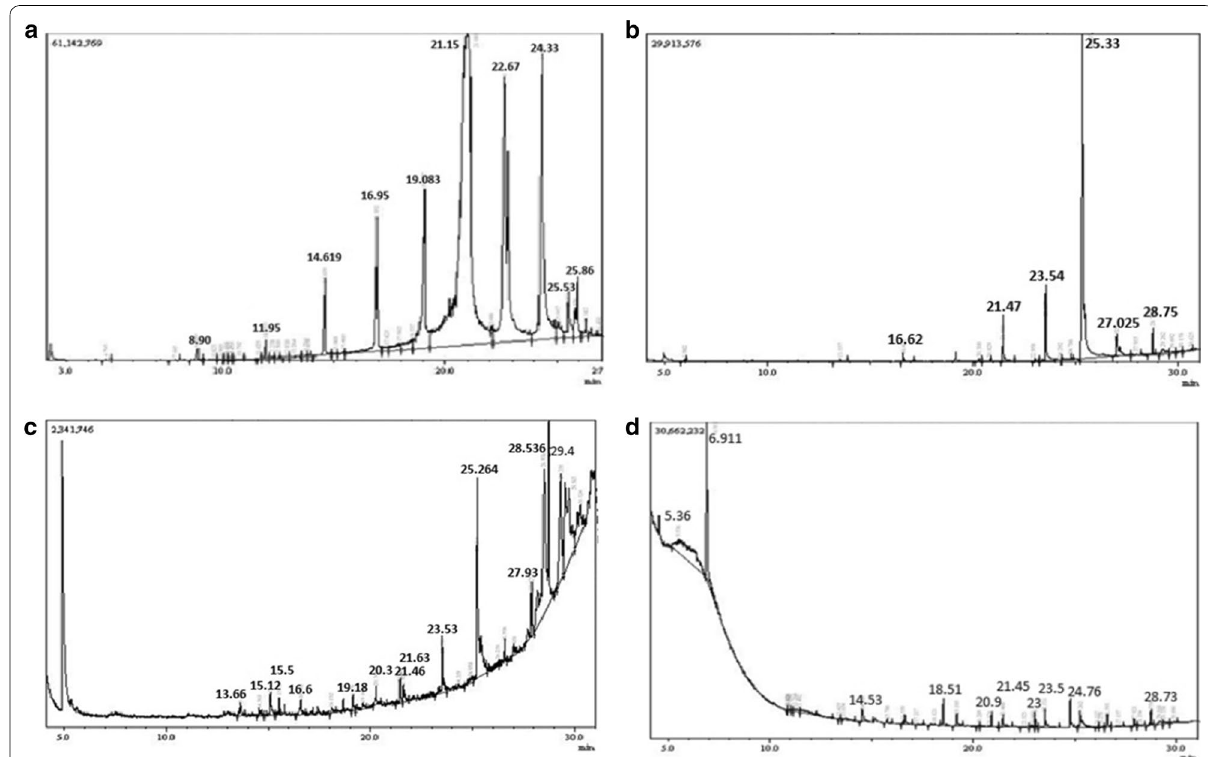
Fig. 1 Gas chromatography coupled with mass spectrometry (GC–MS) chromatogram obtained for J. curcas de-oiled pressed cake extracts and seed oil, a GC–MS chromatogram obtained for J. curcas seed oil, b GC–MS chromatogram obtained for n -hexane extract of J. curcas de-oiled seed cake, c GC–MS chromatogram obtained for methanolic extract of J. curcas de-oiled seed cake, d GC–MS chromatogram obtained for aqueous extract of J. curcas de-oiled seed